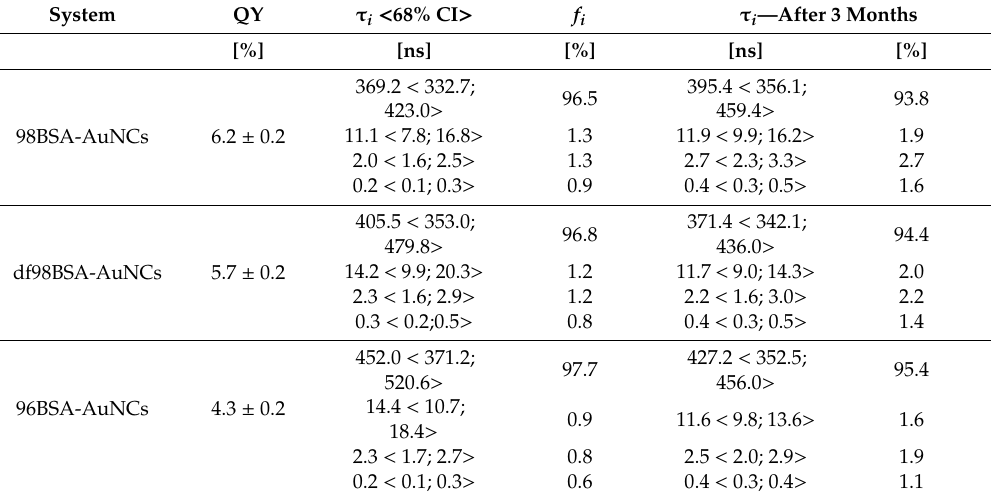
Table 2. Calculated quantum yield (QY), fluorescence decay components of AuNCs with lifetime values ( τ i ) within confidential intervals ( CI ), and corresponding fractional intensities ( f i ) measured for the four-day aged AuNCs. The lifetimes were re-measured after three months and the values ( τ i , f i ) are also